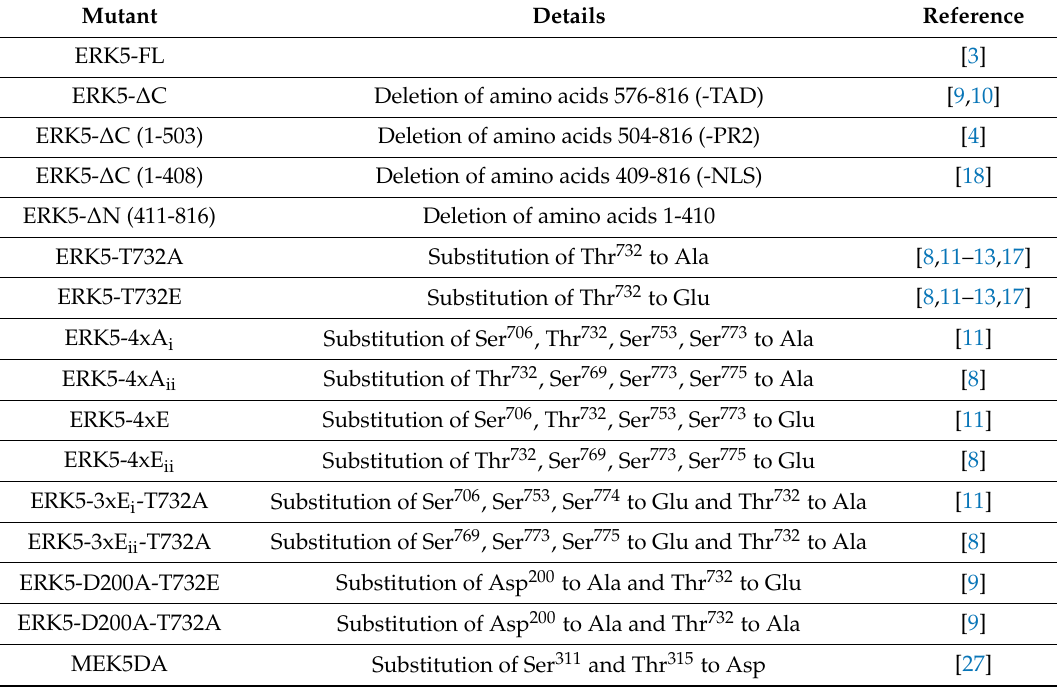
Table 1. ERK5 and MEK5 constructs utilized in this